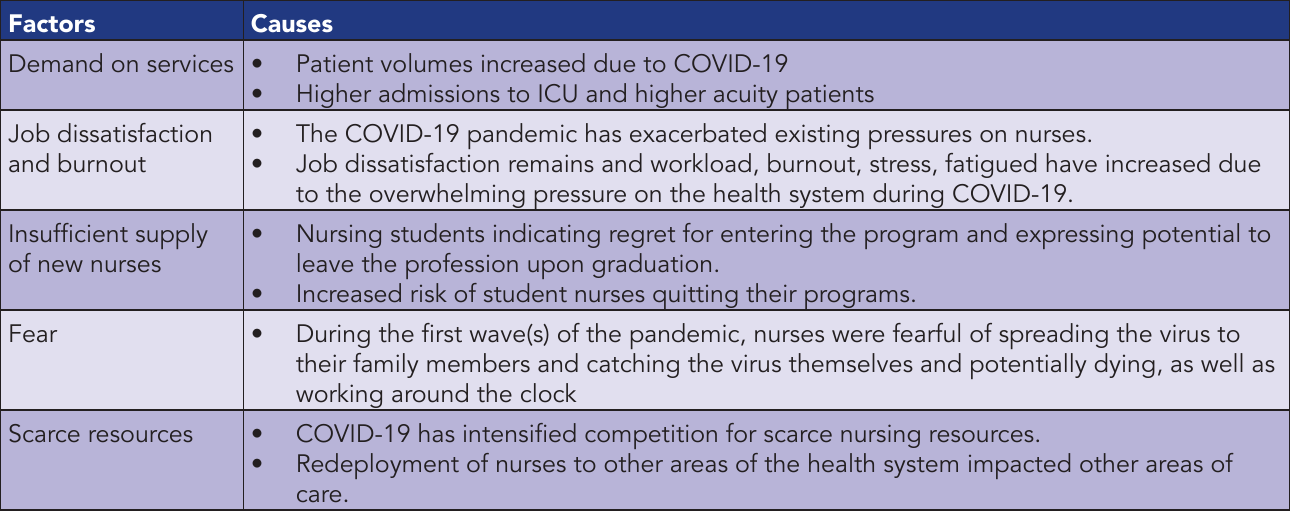
Table 9: Factors contributing to increases in nursing workforce shortages (during COVID-19)